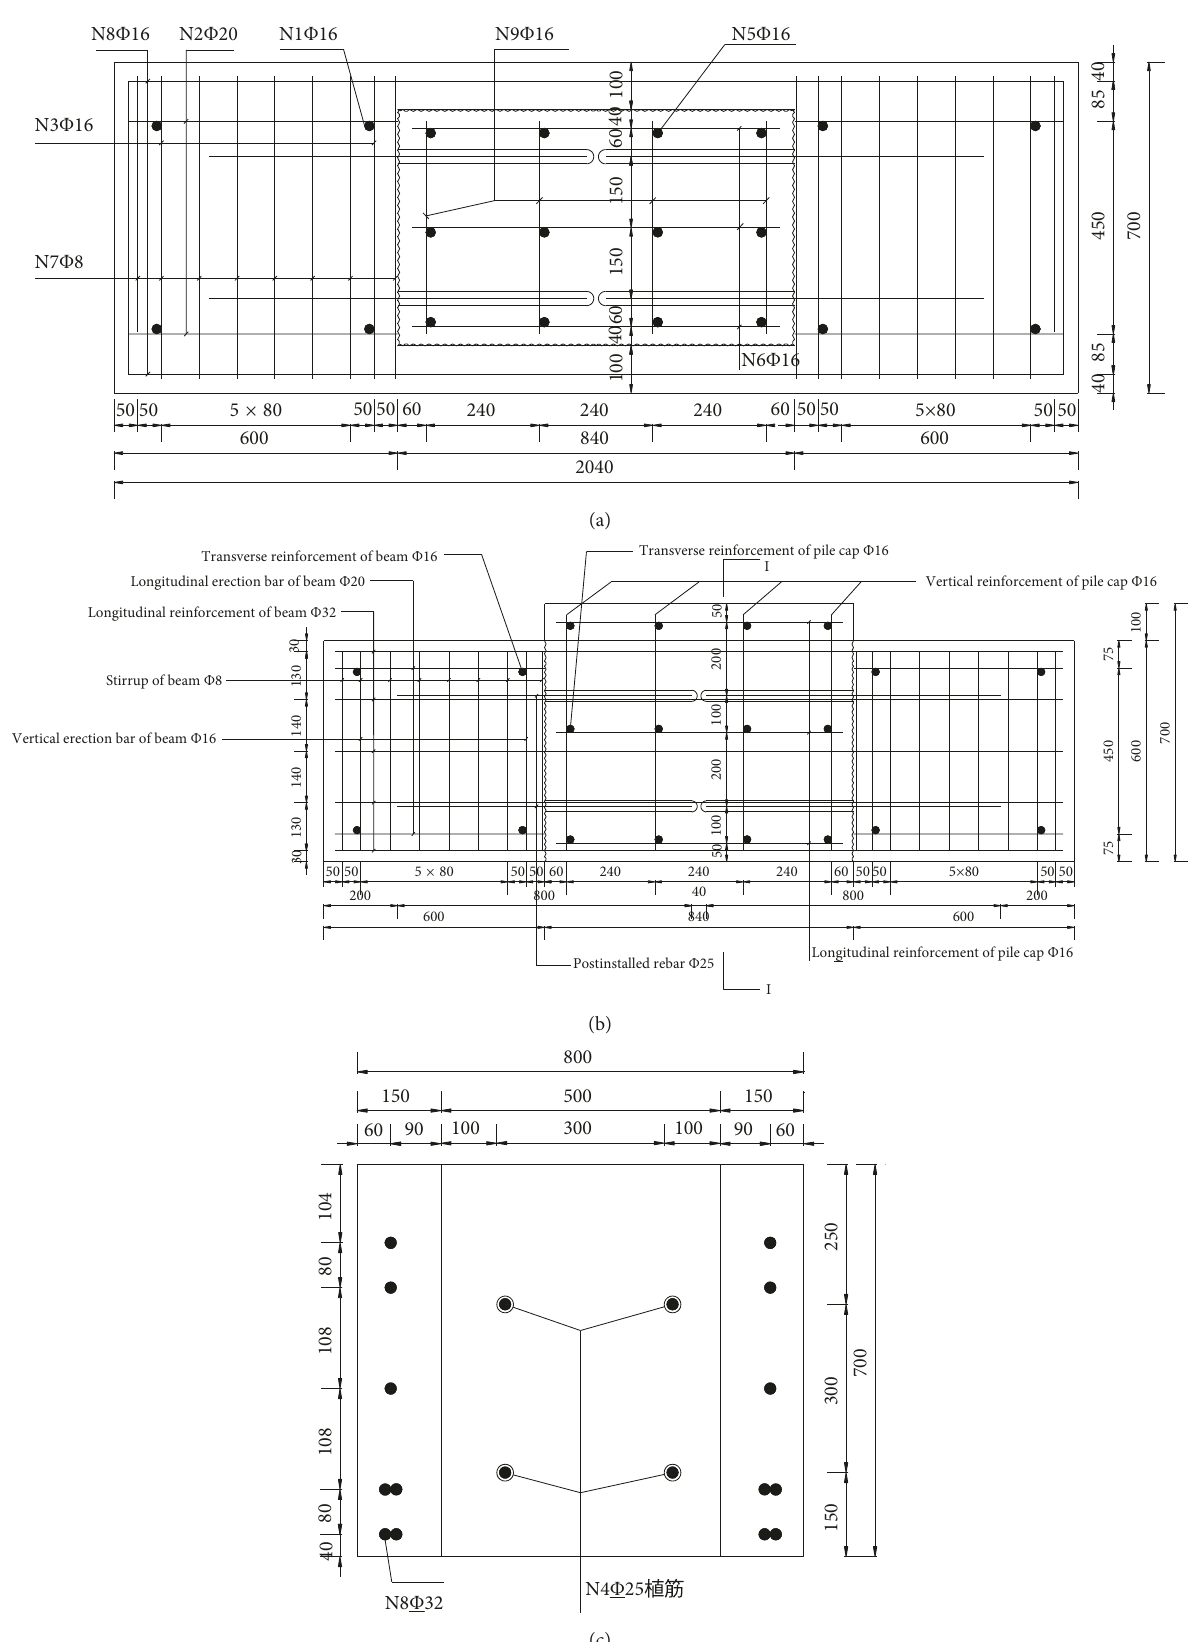
Figure 3: The size and reinforcement of the underpinning beam. Reinforcement assembly of the (a) plane and (b) longitudinal section (unit: cm). (c) I-I